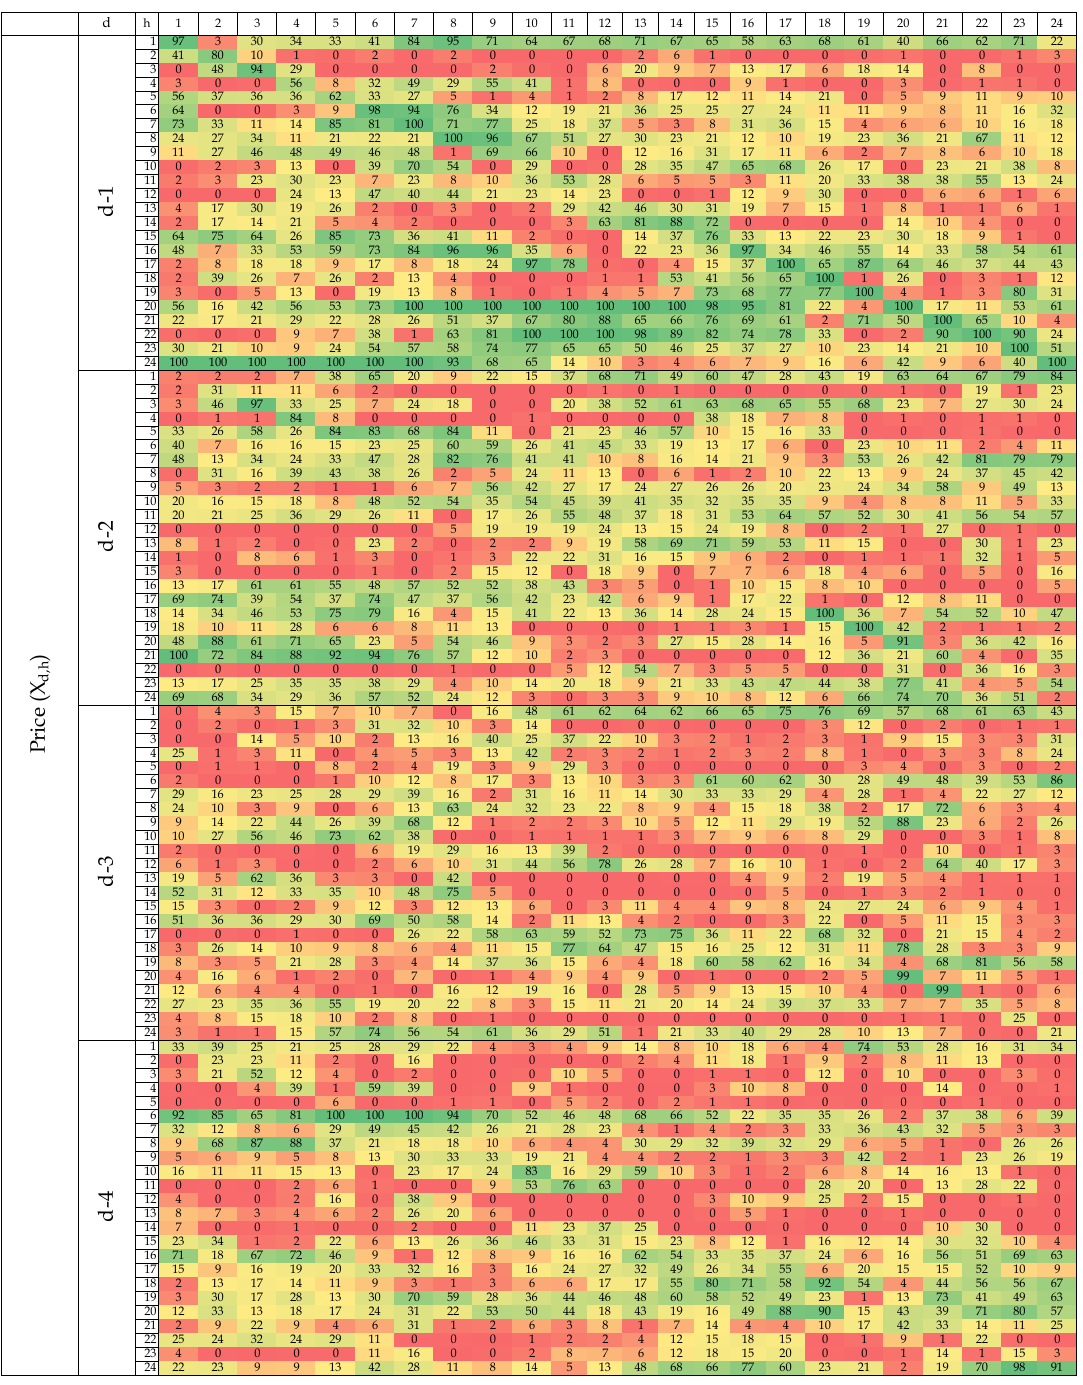
Table 4. Mean occurrence (in %) of model parameters across the 631-day test period. The columns represent the hours and the rows represent the parameters of the 1xN Lasso 182 to N-PIT -transformed PJM data. A heat map is used to indicate more ( → green) and less ( → red) commonly-selected